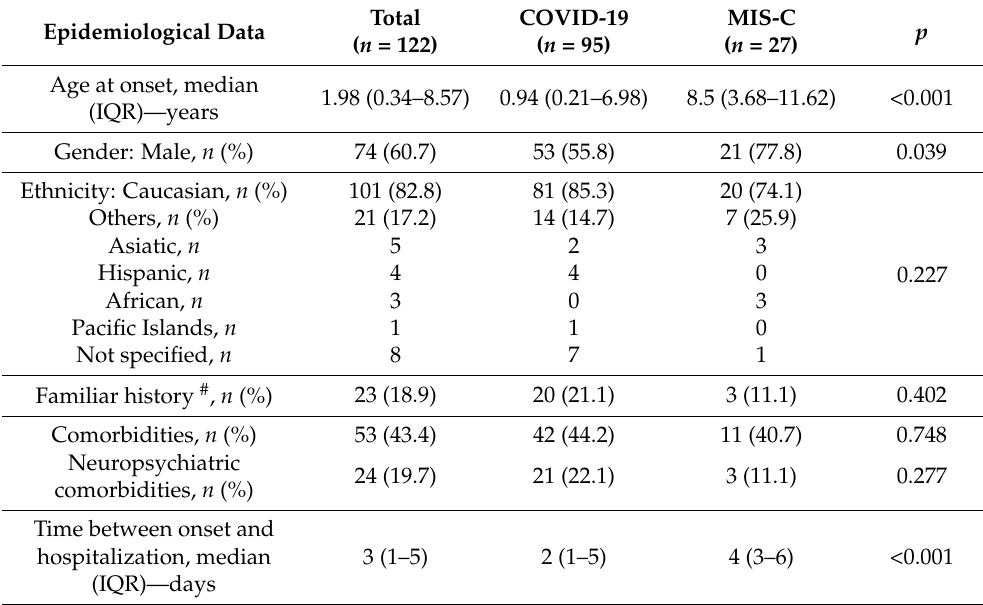
Table 1. Demographic data in the enrolled 122 patients and in the two